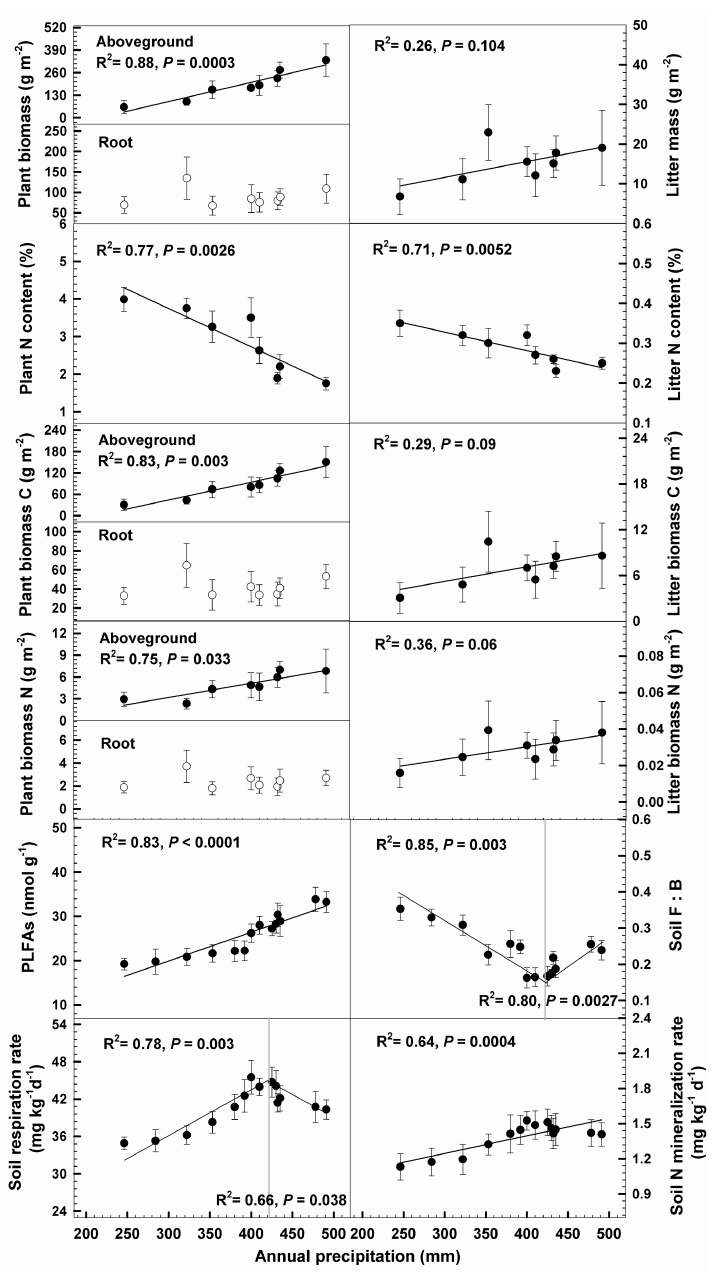
Figure A1. Aboveground and root biomass, plant N content, aboveground and root biomass C, aboveground and root biomass N, litter mass, litter N content, litter biomass C and N, soil microbial biomass (PLFAs), soil fungal:bacterial biomass (F : B), soil respiration rate and soil net N mineralization rate versus annual precipitation in 2012 across the longitudinal